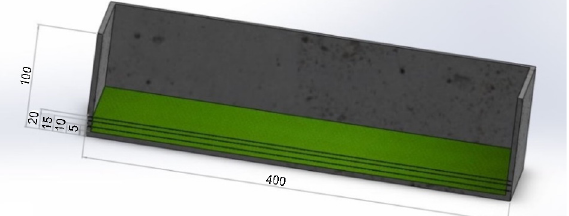
Fig. 3. Group 2 specimens scheme (four warps without fibers are in the specimen)